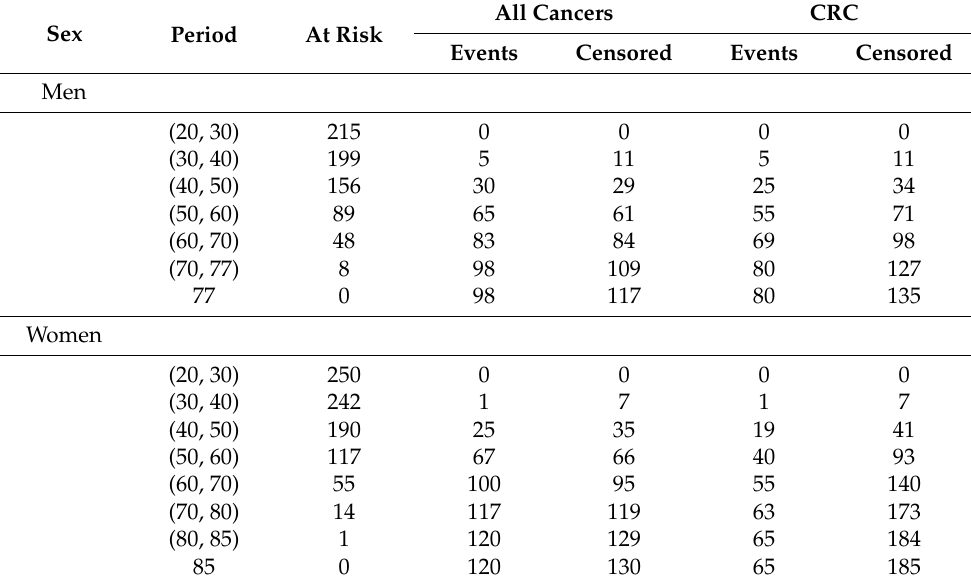
Table 2. Summary of individuals at risk for cancer, events, and censorings occurring at the beginning of 10-year periods for men and women. All Sex Period At Risk